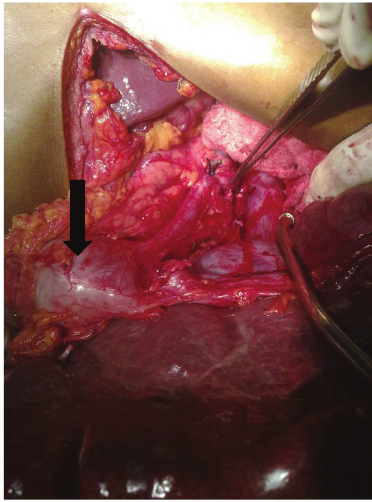
Figure 1: Intraop picture showing splenic artery aneurysm (arrow).